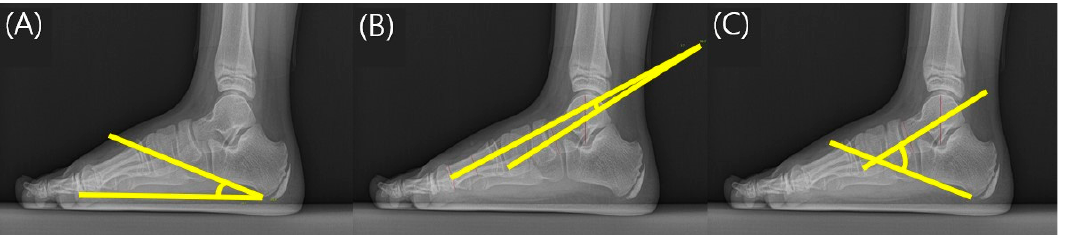
Figure 3. Measurement of radiographic parameters. ( A ) Calcaneal pitch angle; ( B ) Talometatarsal angle; ( C ) Talocalcaneal angle. angle; ( C ) Talocalcaneal